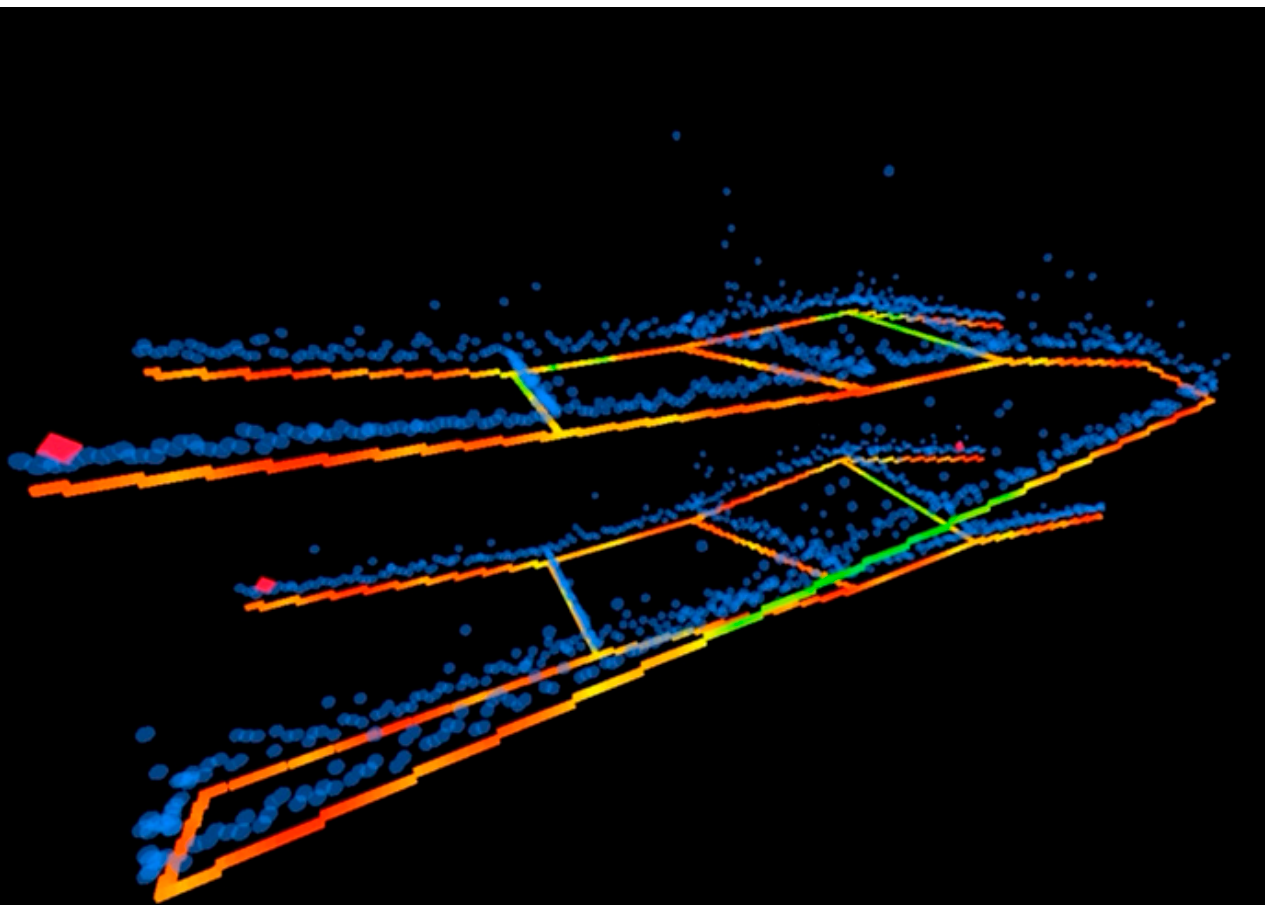
Figure A2. Implementation view of real time 3D visualization system of the emulator.